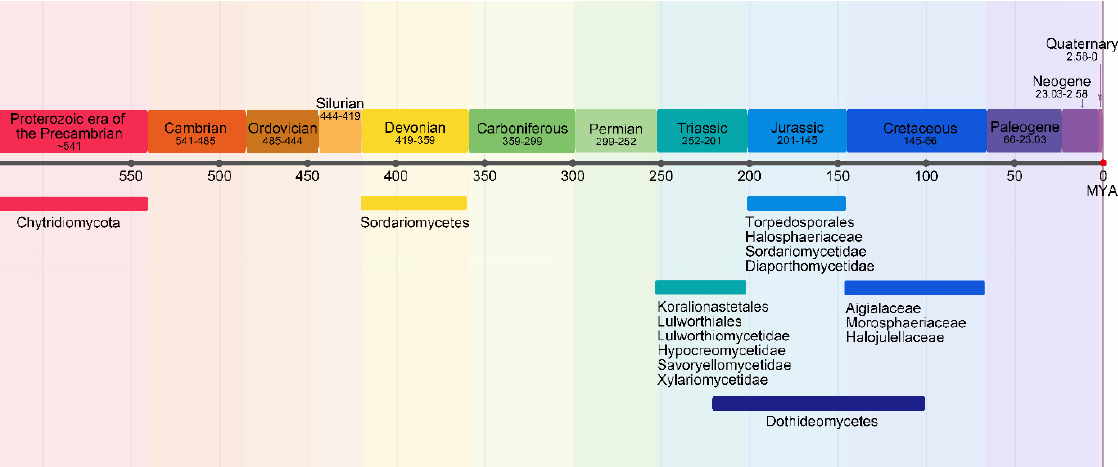
Figure 3. Time of evolution divergence of various groups of marine fungi.